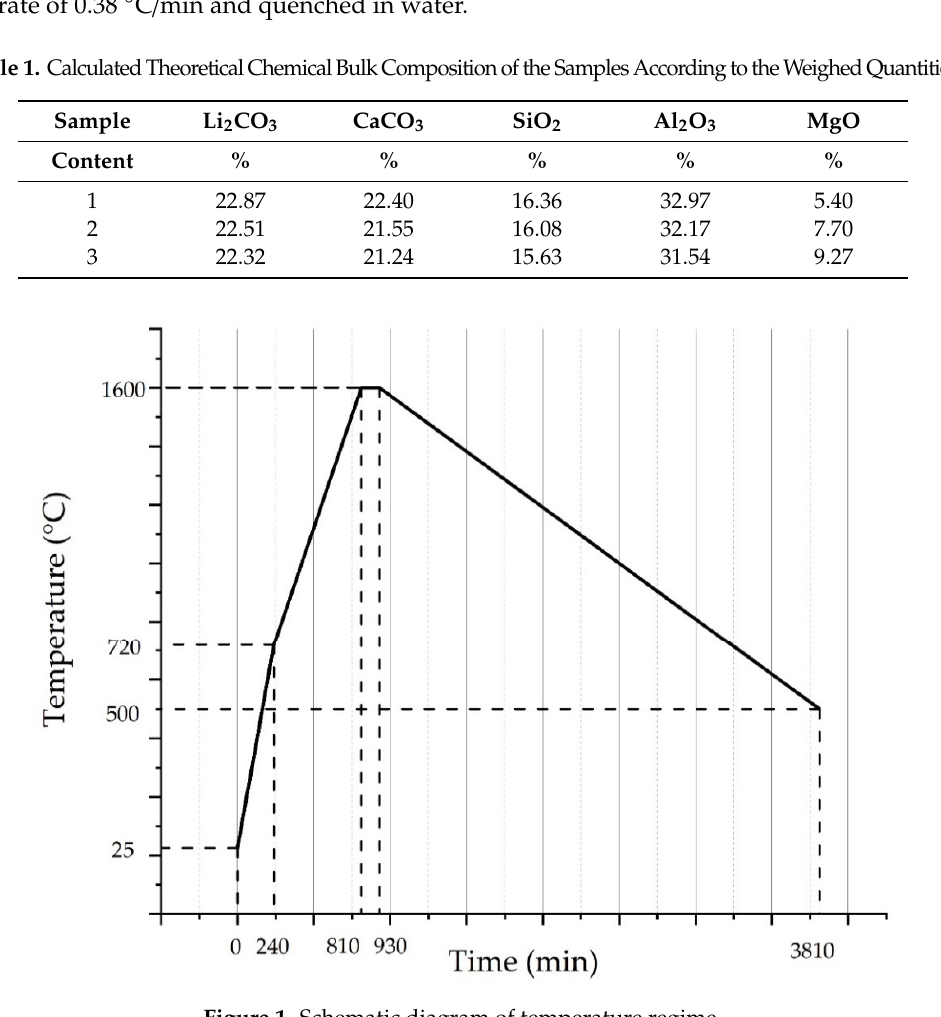
Figure 1. Schematic diagram of temperature regime.